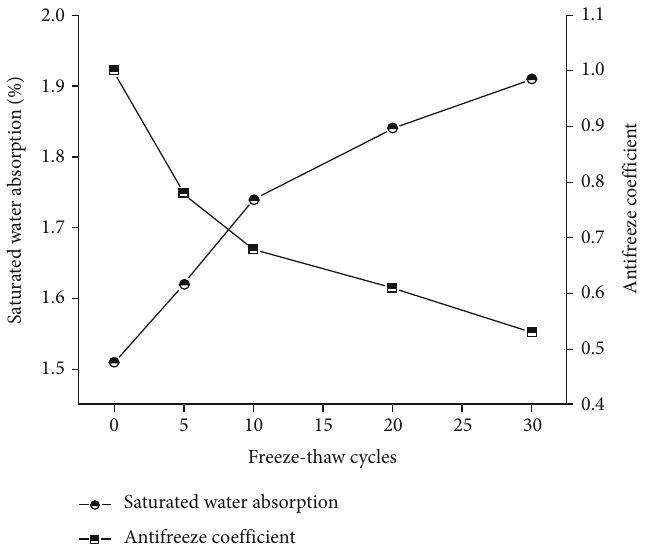
Figure 4: The relationship between the saturated water absorption rate and the frost resistance coe ffi cient of sandstone after various freeze- thaw